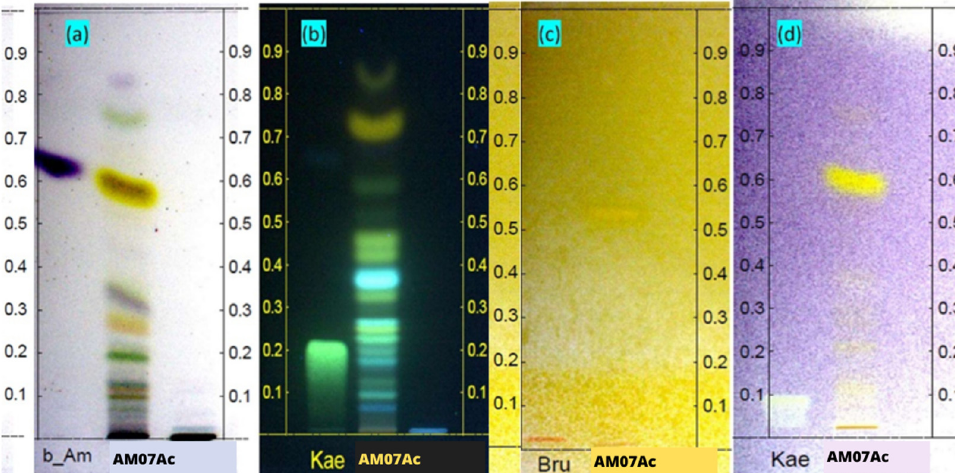
Figure 3. Chemical profile of extracts by HPTLC on chromatoplates derivatized with selective solutions for ( a ) terpenes and steroids in purple compared to the β -amyrin (b_Am) standard; ( b ) flavonoids in green and phenolic compounds in blue compared to the kaempferol (Kae) standard; ( c ) alkaloids in orange compared to the brucine (Bru) standard; ( d ) and antioxidant compounds in yellow compared to the kaempferol (Kae) standard. Standards were compared with T. asperellum crude extract